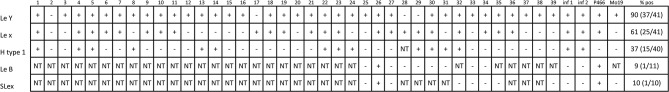
Expression of blood group related antigens by 41 H. pylori clinical isolates as detected by a panel of monoclonal antibodies. A and B = H. pylori strains from the two patients with previous myocardial infarction. NT, not tested. P466 and Mo19 = two reference H. pylori strains.